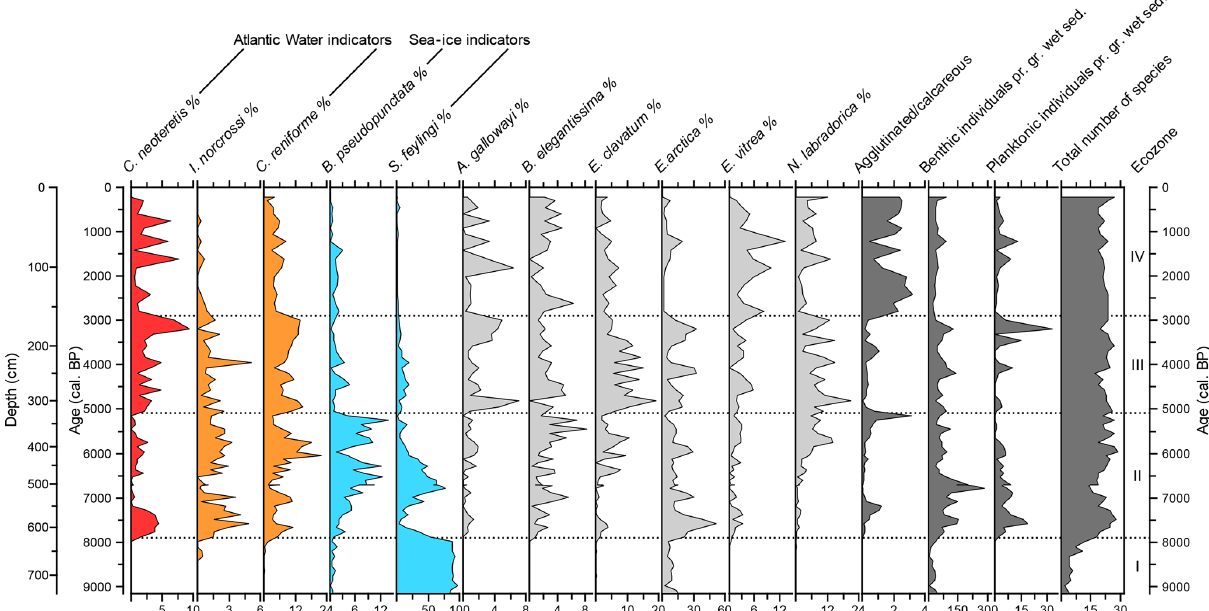
Figure 4. Downcore distribution of the most abundant ( > 4% in at least one sample) calcareous benthic foraminiferal species. Ecozones (I to IV) are shown on the right side of the figure. Relative abundances are calculated based on the entire benthic (calcareous and agglutinated) foraminiferal assemblage. Some species are grouped (colour shading) according to their known environmental preferences (see references in text) as follows: red: warm Atlantic Water; orange: chilled Atlantic Water; light blue: sea